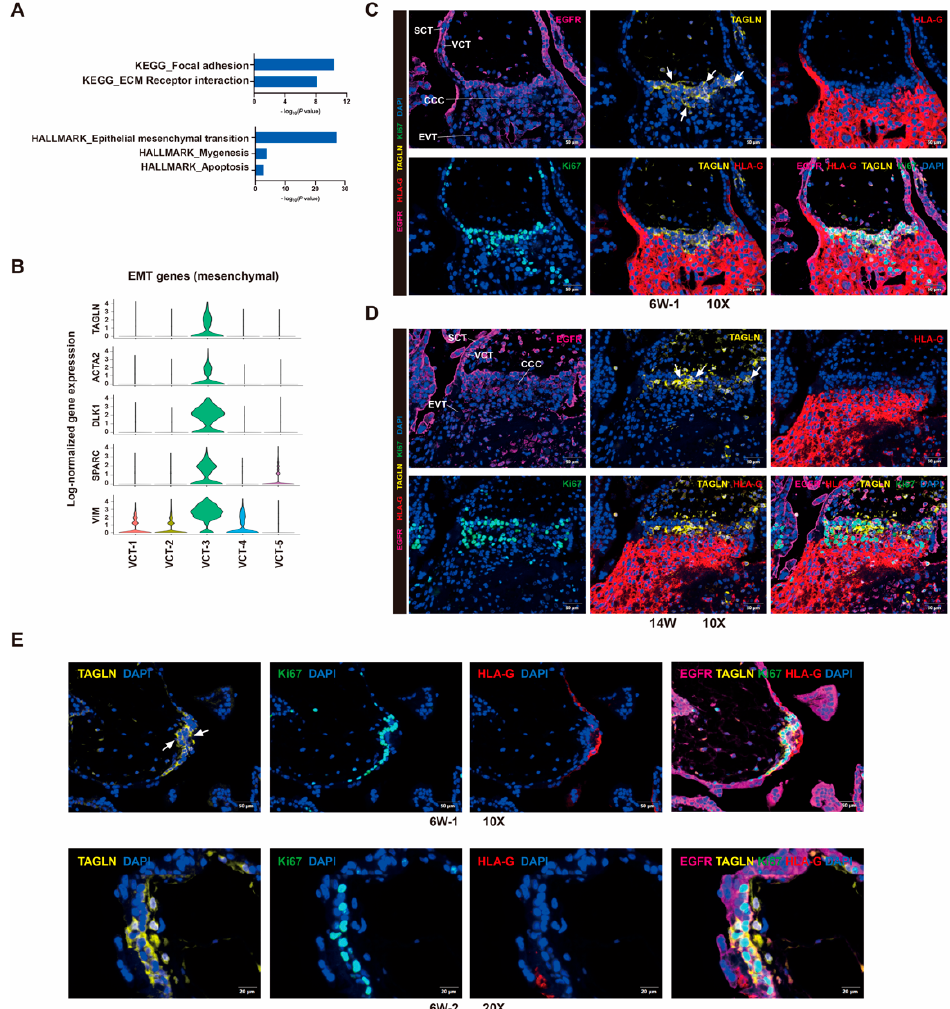
Figure 5. Human trophoblast progenitor cells contribute to EVT lineages. ( A ) Selected top categories from KEGG and Cancer Hallmark analysis of differentially expressed genes in VCT-3. ( B ) Violin plots showing the relative expression of EMT genes in each VCT cluster. ( C , D ) Immunofluorescence staining for the indicated VCT-3 marker TAGLN, trophoblast marker EGFR, EVT marker HLA-G, proliferative cell marker Ki67 in cytotrophoblast cell columns structures of 6 weeks of gestation ( C ) and 14 weeks of gestation ( D ) placental tissue. Scale bars, 50 μ m ( E ) Immunofluorescence staining for TAGLN in the two-layer cell structure of 6 weeks of gestation placental villi. The white arrowheads indicated VCT-3 cells, which were TAGLN and EGFR double positive, and HLA-G negative. Scale bars, 50 μ m for 10× and 20 μ m for 20×.